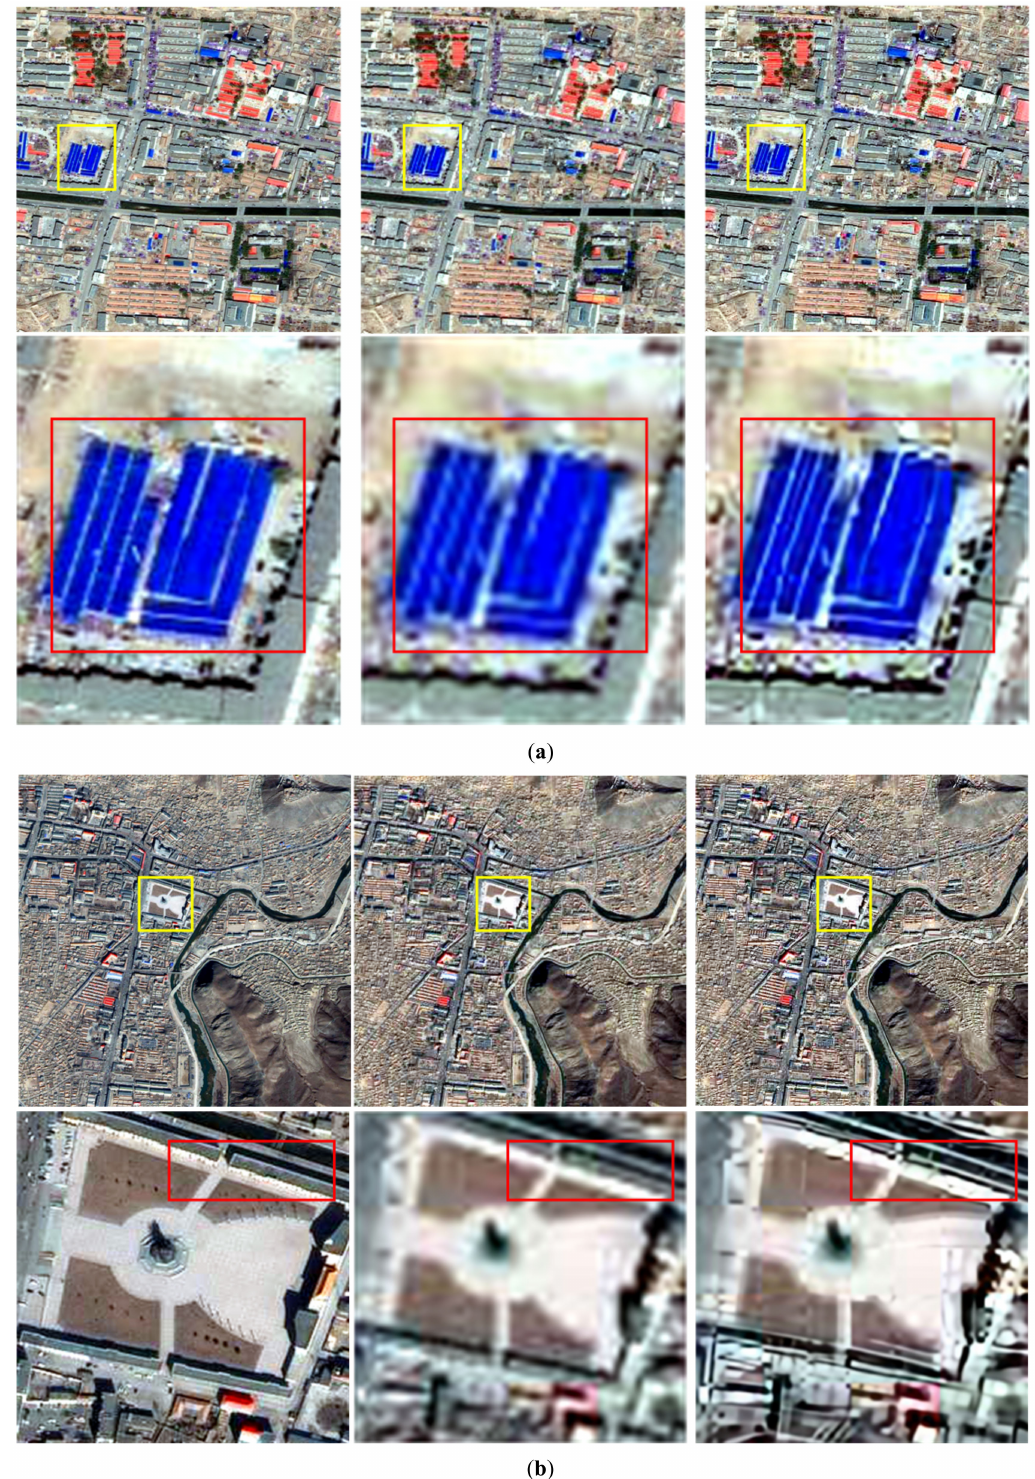
Figure 13. Selection of different bands belonging to the same remote-sensing image to combine them, yielding a spatial resolution of 1 m for the high-resolution (HR) image and spatial resolutions of 2 m and 4 m for the low-resolution (LR) images. Comparison of the SR reconstruction effects of the Bicubic model and PMSRN. (Left to right) Images with 1 m spatial resolution, Bicubic model results, and PMSRN outcomes. The up-sampling factors r value is ( a ) 2 and ( b ) 4. The images on the left of Figure 13a,b show images with a spatial resolution of 1 m, which are only used as HR images for visual comparison. The images in the middle